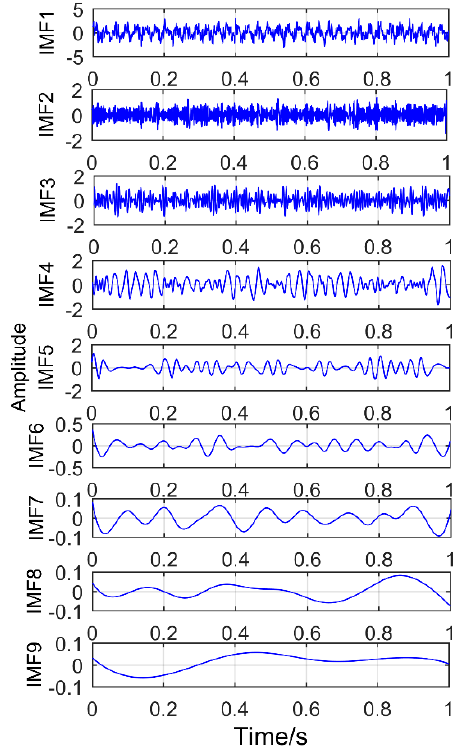
Figure 20. The results decomposition obtained by EEMD.